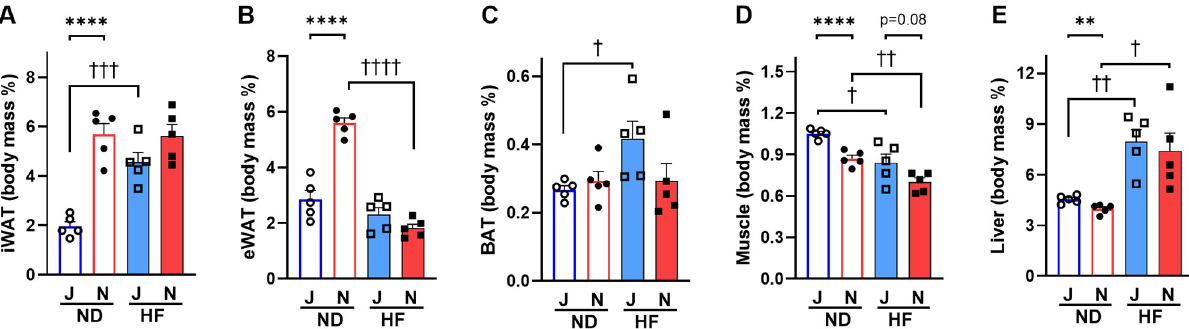
Fig 2. Tissue weights in B6J and B6N mice on ND or HF. Relative tissue weights were calculated by organ weight/body weight (body mass percentage). (A) iWAT, inguinal white adipose tissue; (B) eWAT, epididymal white adipose tissue; (C) BAT, brown adipose tissue; (D) Muscle, skeletal muscle; and (E) Liver. Values are means + SEM (n = 5) for B6J group (blue color) and B6N group (red color). Two-way ANOVA indicated a significant interaction between substrain and diet for iWAT ( p < 0.01; F = 11.96; Df = 16) and eWAT ( p < 0.0001; F = 47.48; Df = 16). There was a significant effect of strain on muscle ( p < 0.001; F = 18.46; Df = 16) independent of diet, and significant effect of diet on muscle ( p < 0.001; F = 25.63; Df = 16) and on liver ( p < 0.0001; F = 27.80; Df = 16) independent of strain. Individual means were compared within groups using unpaired Student’s t -test. Asterisks ( � ) and daggers (†) indicate significant differences between B6J and B6N substrain groups, and ND and HF diet groups, respectively ( �� p < 0.01 and ���� p < 0.0001, † p < 0.05, †† p < 0.01, ††† p < 0.001, and †††† p < 0.0001). J, B6J substrain; N, B6N substrain; ND, normal diet; HF, high-fat diet; open circles, ND-fed B6J; filled circles, ND-fed B6N; open squares, HF-fed B6J; filled squares, HF-fed